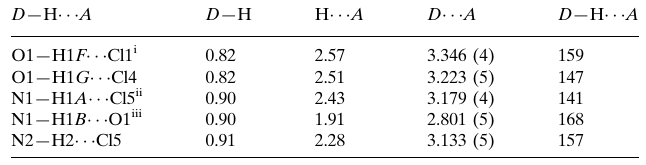
Hydrogen-bond geometry (A˚ , (cid:2)